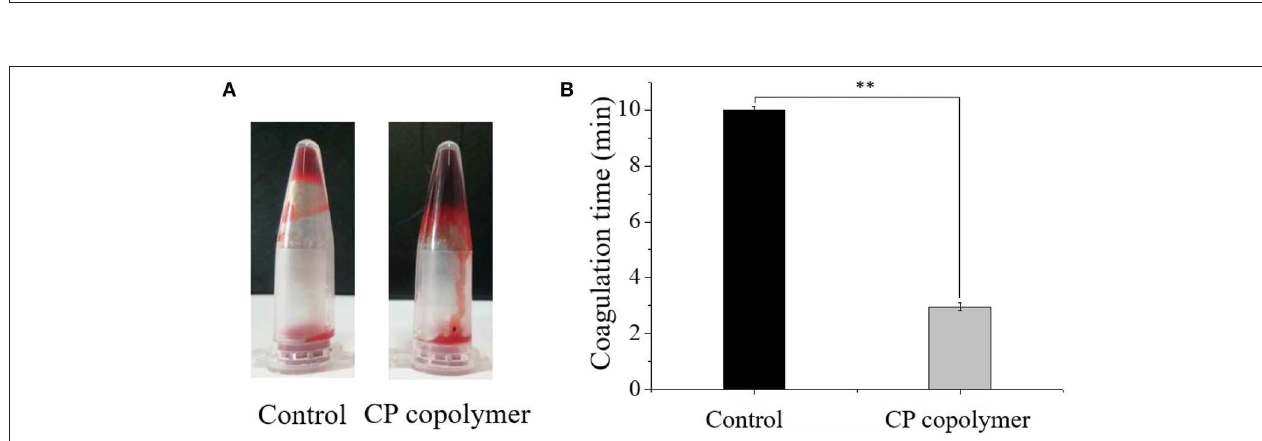
FIGURE 3 | (A) Cell viability of human gingival fibroblast cells treated with the CP copolymer (0–1,000 µ g/mL). (B) Cell growth (OD 450 ) following the treatment of human gingival fibroblasts with the CP copolymer.* p < 0.05.